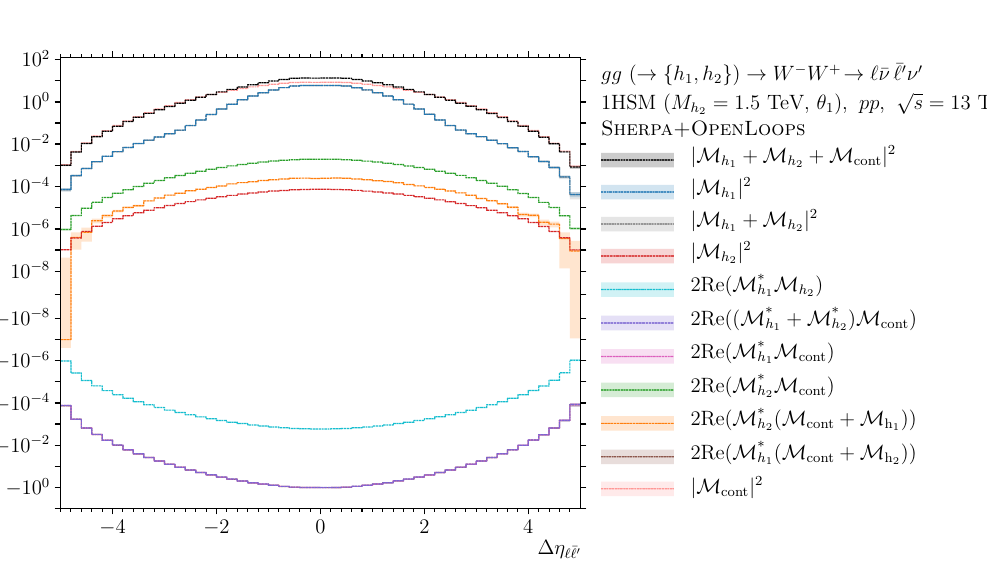
h 1 , h 2 ) W − W + (cid:26) ¯ ν ¯ (cid:26) (cid:30) ν (cid:30) in → { } → →